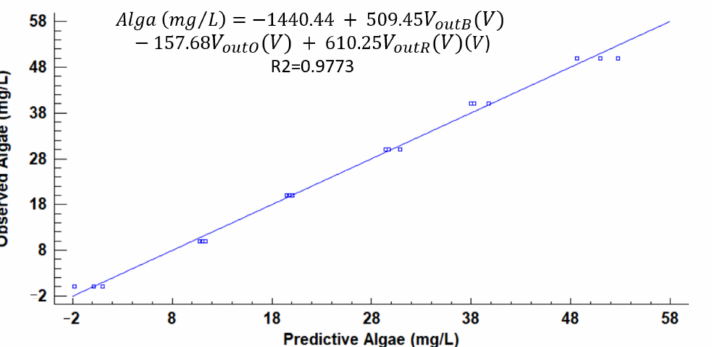
Figure 13. Observed vs. predicted values of algae concentration with a solid concentration of 50